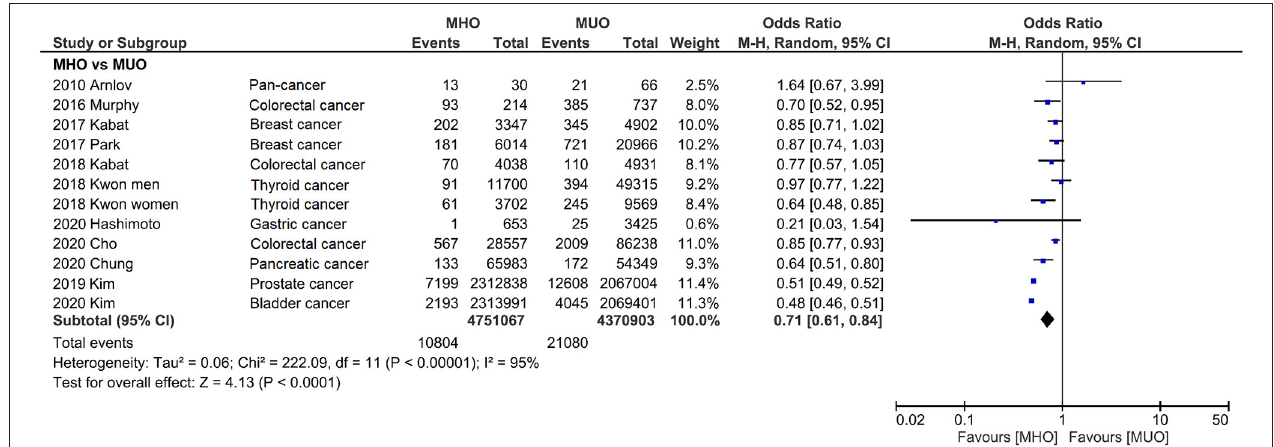
FIGURE 2 | Forest plot that compares cancer incidence between metabolically healthy obesity and metabolically unhealthy obesity. Cancer incidence is significantly lower for metabolically healthy obesity.